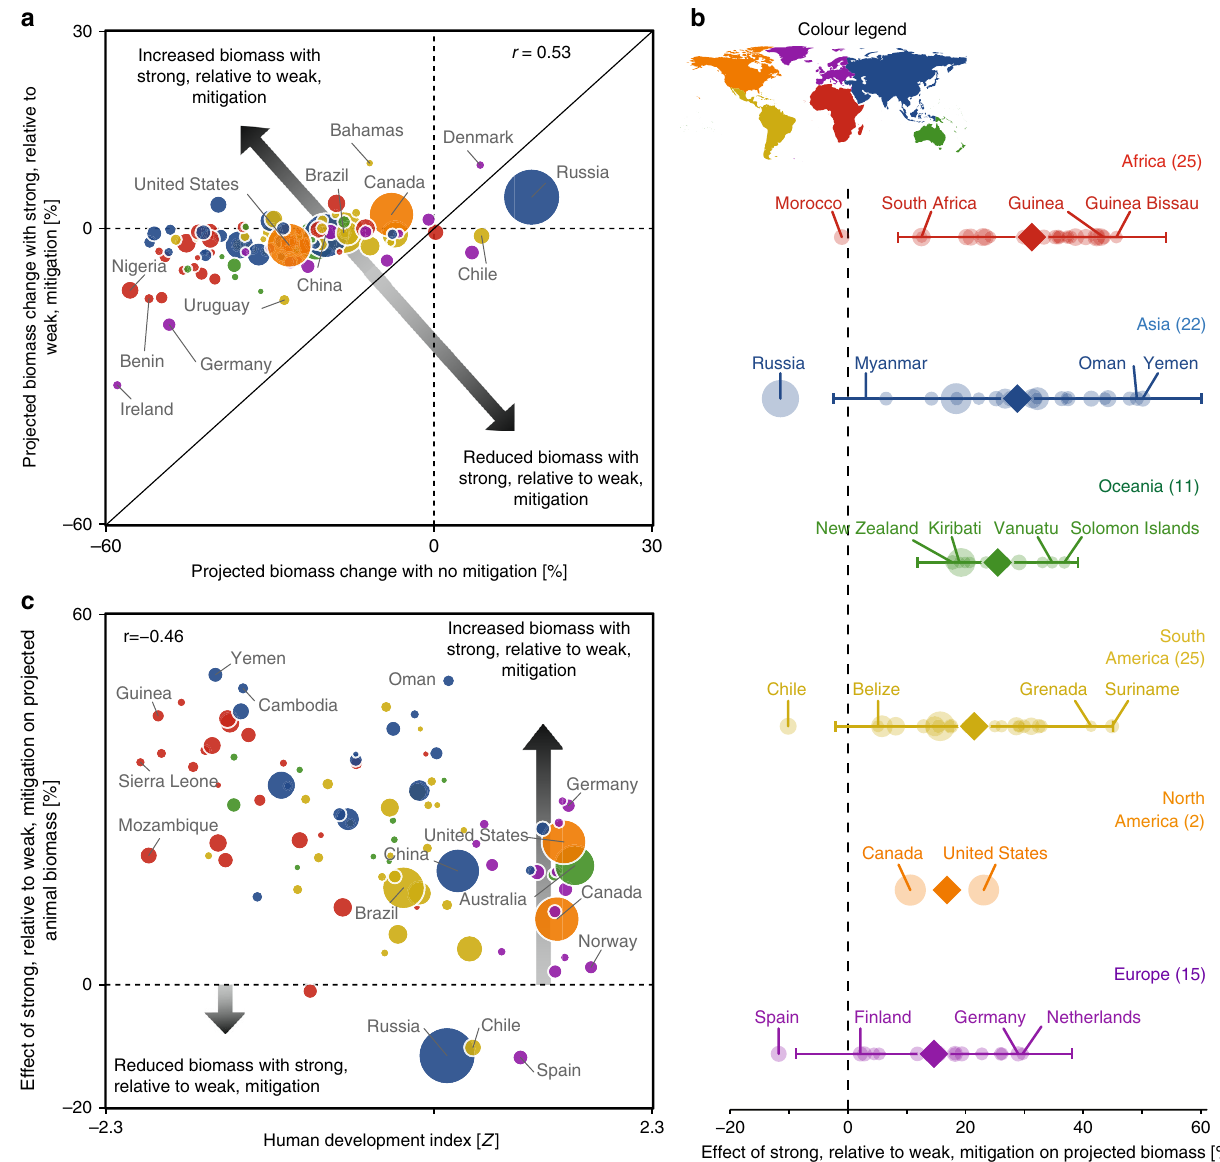
Fig. 4 Effects of emission mitigation on projected animal biomass change. a Relationship between average projected animal biomass change across EEZs under a worst-case (RCP8.5) vs. strong mitigation scenario (RCP2.6). Horizontal and vertical dashed lines denote no change in projected biomass. The solid line represents a 1:1 relationship; points above this line depict EEZs in which strong (RCP2.6), relative to weak (RCP8.5), mitigation leads to greater biomass and vice versa. b Change in projected animal biomass resulting from strong, relative to weak mitigation within maritime EEZs (semitransparent circles) summarized within major continents (colors). The mean effect of emission mitigation on animal biomass for each continent is shown as opaque symbols with lines denoting the 95% CIs where n > 3. The number of EEZs is in parentheses. Points to the right of the vertical line denote biomass increases with strong emission mitigation relative to the worst-case scenario. c Effect of strong, relative to weak, mitigation on projected animal biomass within EEZs in relation to development status. Points above the horizontal line depict increased animal biomass with strong, relative to weak, mitigation and vice versa. For a – c , symbol size depicts the size of the EEZs and colors the continent; orange = North America, yellow = South America, purple = Europe, red = Africa, blue = Asia, and green =